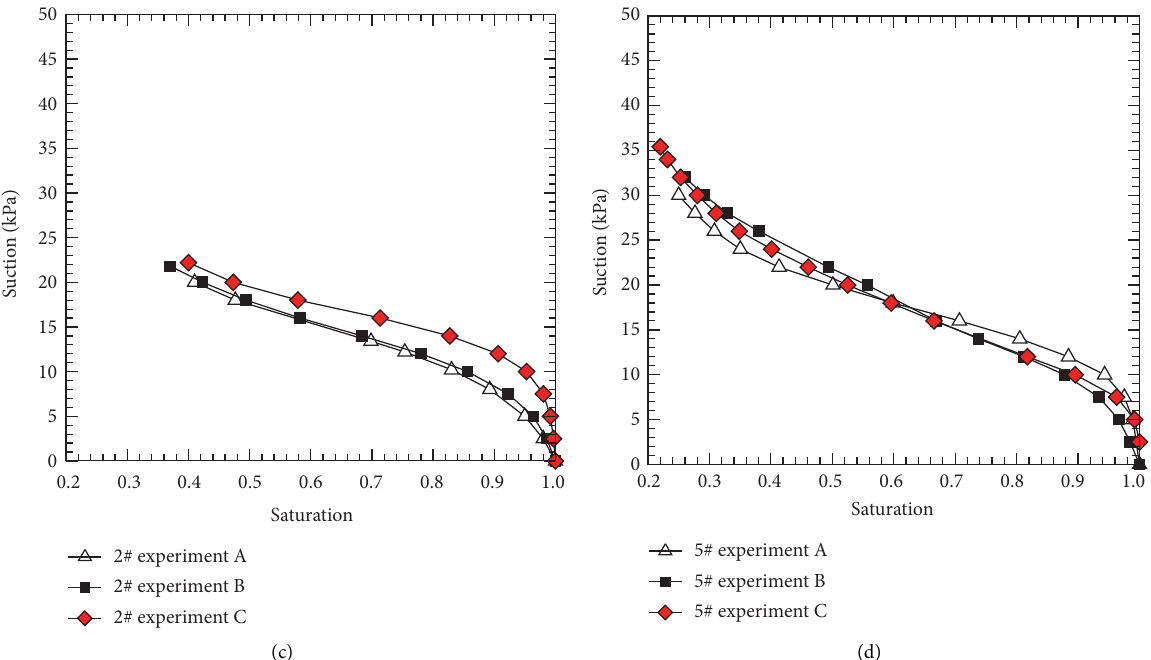
Figure 5: Relationships between matrix suction and saturation tensiometers located at different depths of (a) 1# (250 mm depth), (b) 4# (250 mm depth), (c) 2# (150mm depth), and (d) 5# (150mm depth).